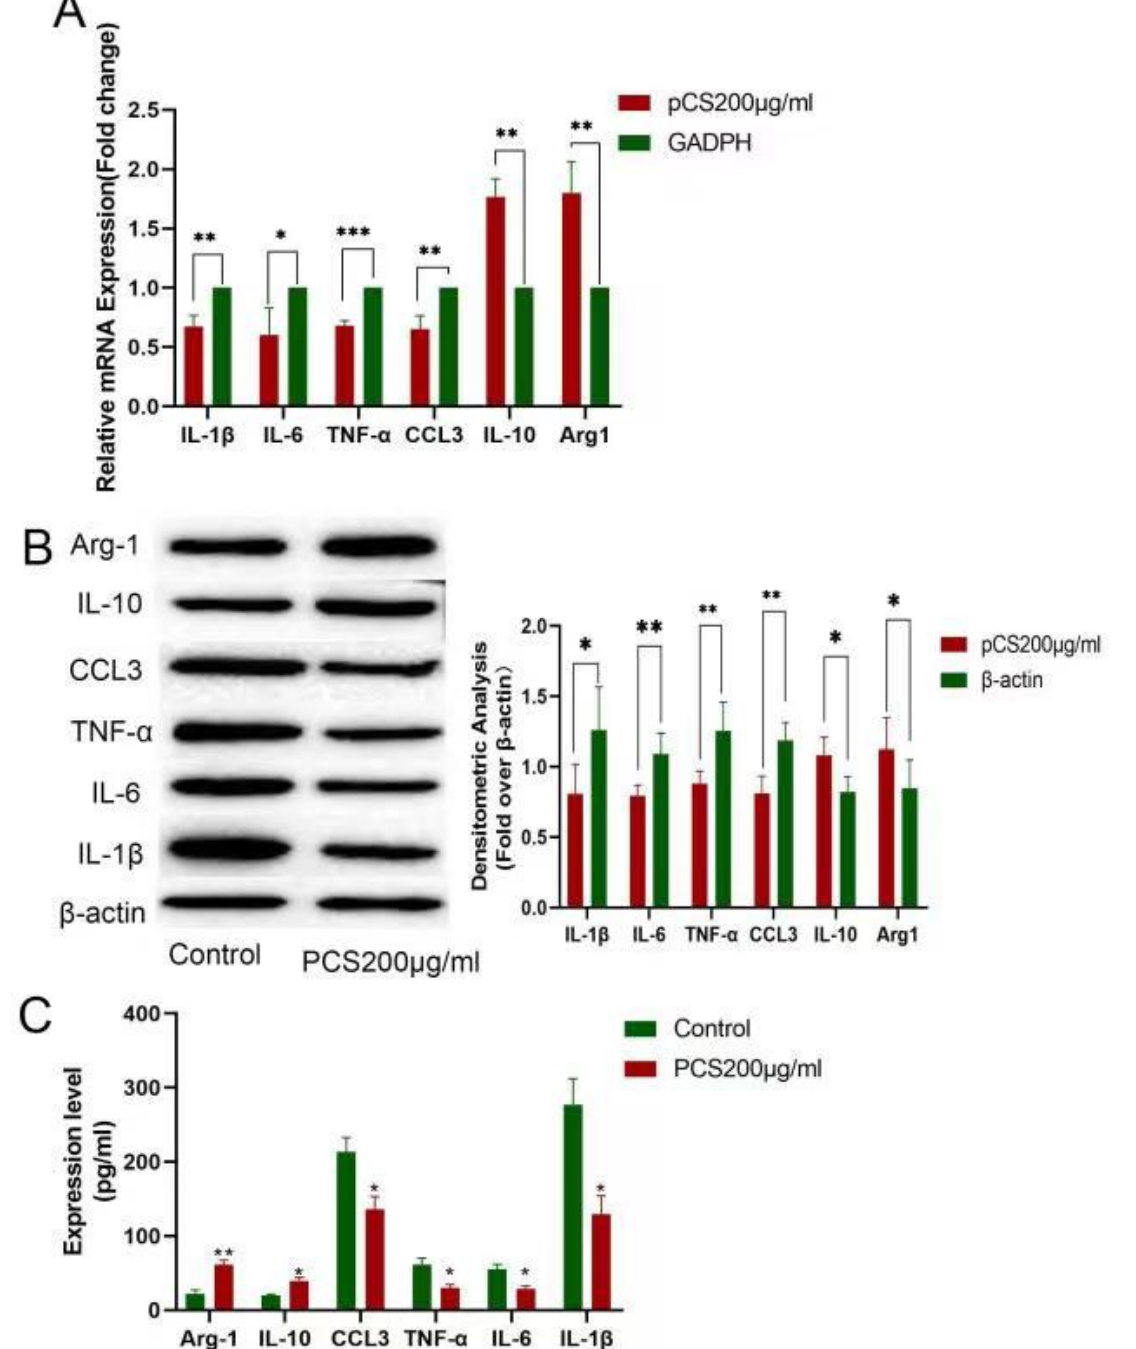
Figure 5. The effect of PCS on Kupffer cells in vitro. ( A ) mRNA and ( B ) protein levels of IL-1 β , IL-6, TNF- α , CCL3, IL-10, and Arg-1. ( C ) ELISA confirmation of the same levels in culture supernatant. PBC model group ( n = 7), normal control group ( n = 10), and PBC tyrosine treatment group ( n = 8). * p < 0.05, ** p < 0.01, and *** p < 0.001.